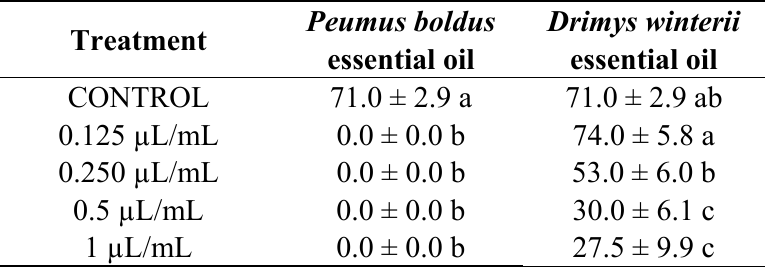
Table 2. Effect of Peumus boldus and Drimys winterii essential oils on Portulaca oleracea seeds germination.